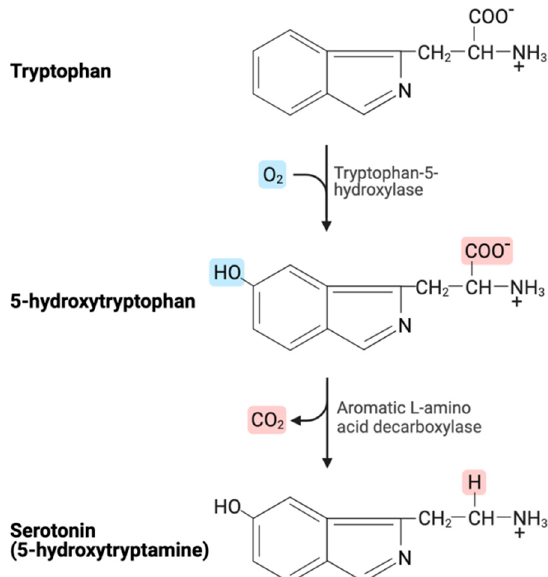
Figure 1. Tryptophan metabolic pathway.